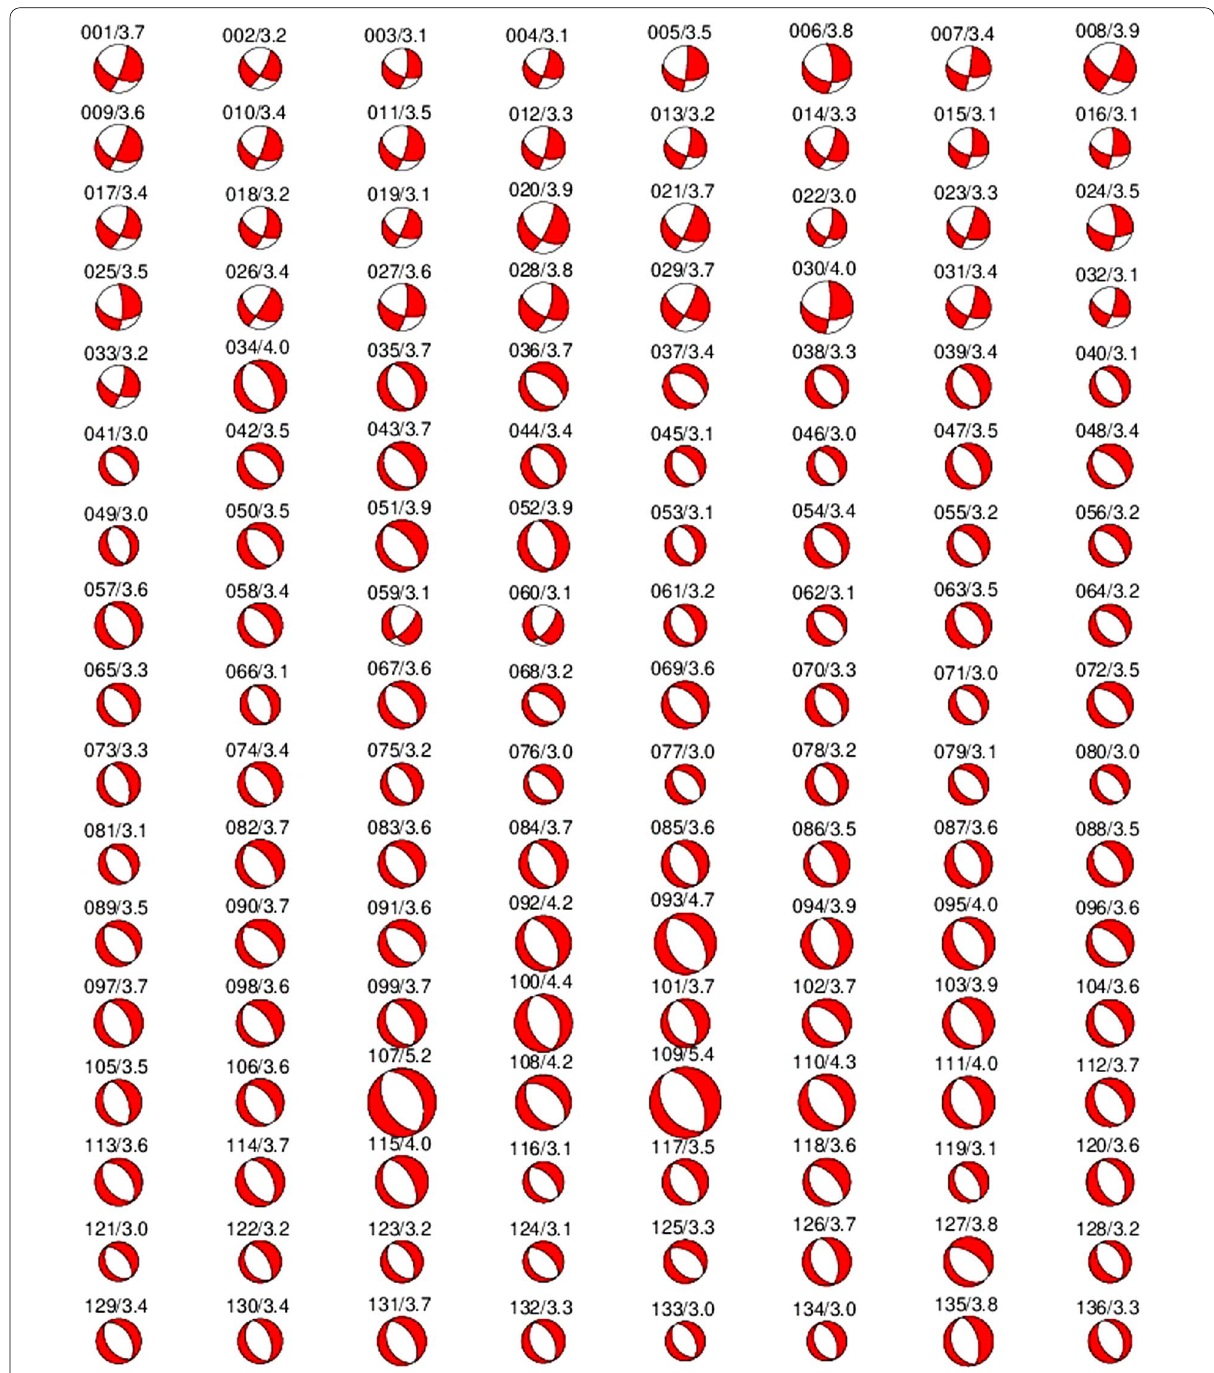
Fig. 10 Fault plane solutions derived by the waveform inversion for the events analyzed in this study. The size of beach-balls is scaled in the corresponding magnitudes. The numbers above each beach-ball denote to the successive event number and to the corresponding magnitudes as listed in Additional file 1: Table S1. The spatial distribution of focal mechanisms shows the consistency with the alignments of hypocenters and the nodal planes that showed sinistral strike-slip movement on the NE fault trend and normal faulting mechanism on the NW fault